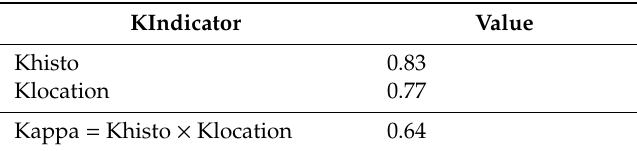
Table 8. Model validation (Kappa statistics). Kappa value of < 0.00 = poor; 0.00–0.20 = slight; 0.21–0.40